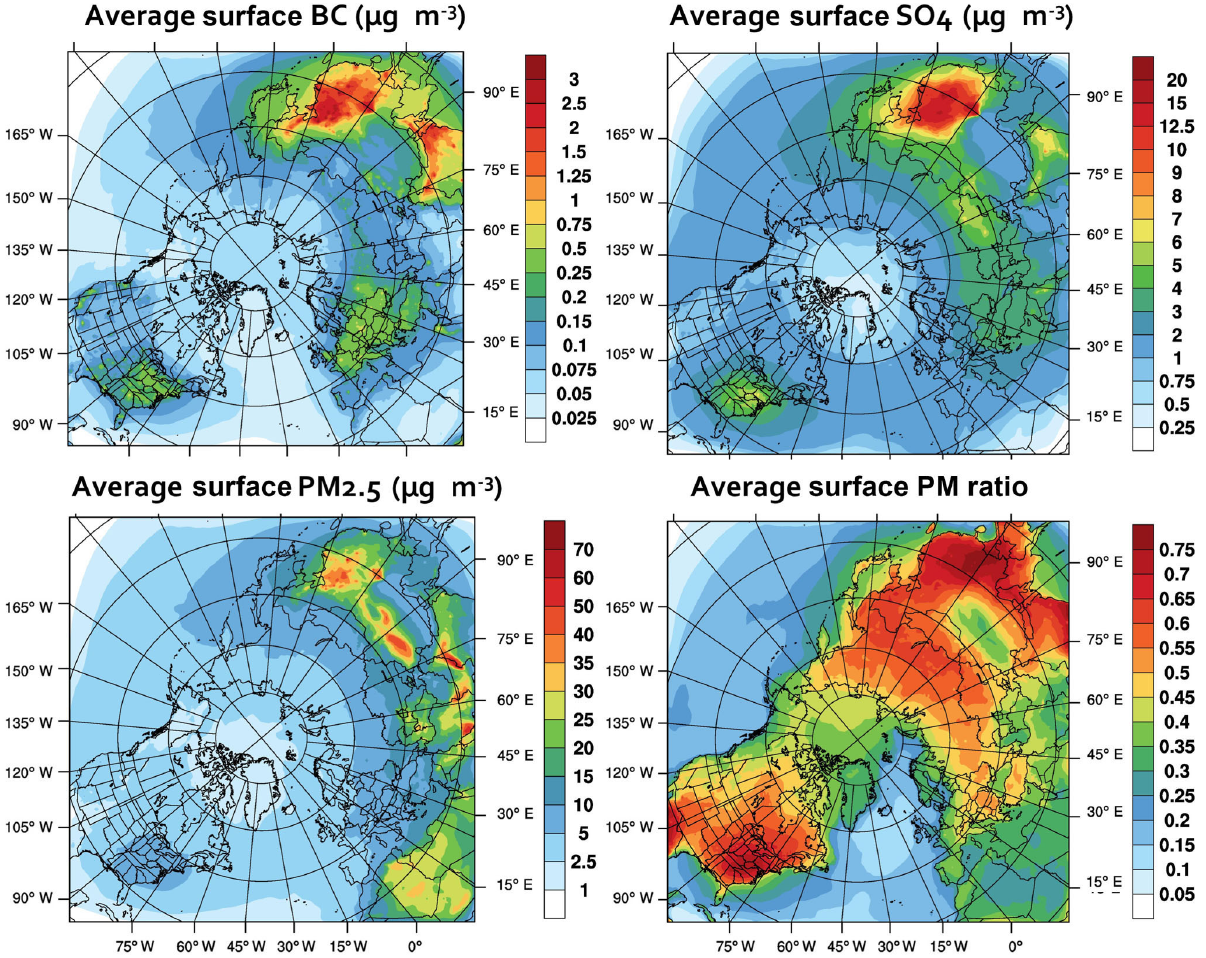
Figure 8. Spatial distributions of simulated BC (µgm − 3 ), sulfate (SO 4 ) (µgm − 3 ), PM 2 . 5 (µgm − 3 ), and PM 2 . 5 / PM 10 ratio averaged over the simulation period. The annual averages are calculated by averaging model outputs from 1 April 2008 to 31 March 2009. This figure is generated using NCAR Command Language (NCL) version 6.3.0, open-source software free to the public, by UCAR/NCAR/CISL/TDD, http://dx.doi.org/10.5065/D6WD3XH5 (last access: 13 November